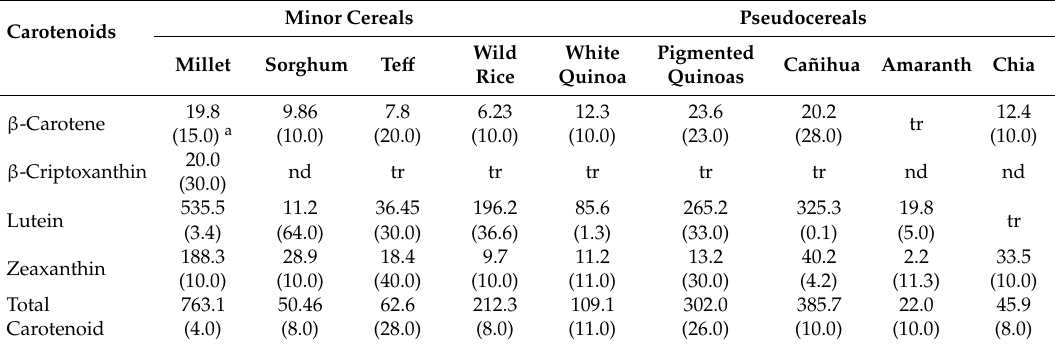
Table 3. Carotenoid composition in gluten-free grains ( µ g / 100 g